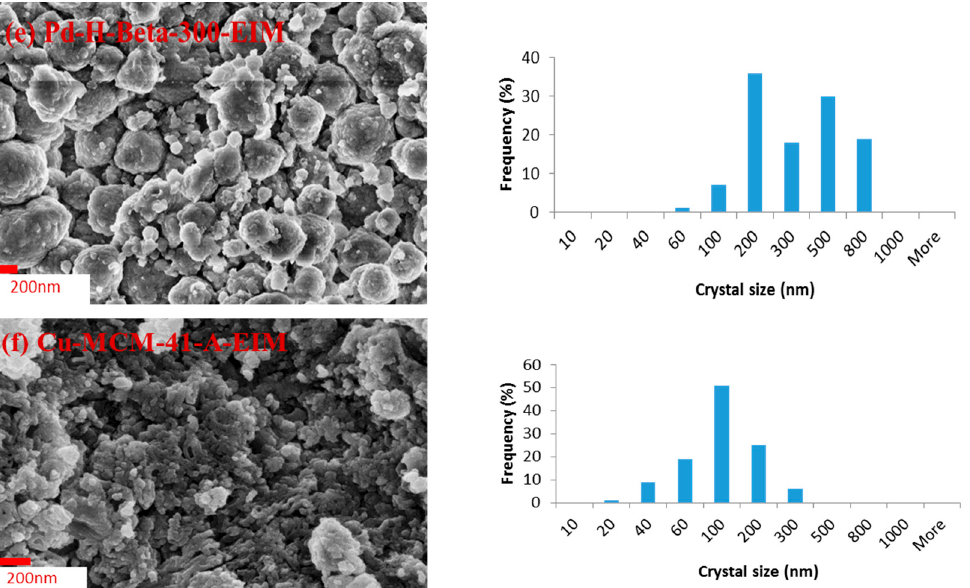
Figure 2. SEM image and crystal size distribution histogram of ( a ) Pt-MCM-41-IS. ( b ) Ru-MCM-41-IS catalyst. ( c ) Pd-H-Y-12-EIM. ( d ) Pt-H-Y-12-EIM. ( e ) Pd-H-Beta-300-EIM and ( f ) Cu-MCM-41-A-EIM catalysts. Table 3. Average crystal size and metal (Pt, Ru, Pd and Cu) content of Pt-MCM-41-IS, Ru-MCM-41- IS, Pd-H-Y-12-EIM, Pt-H-Y-12-EIM, Pd-H-Beta-300-EIM and Cu-MCM-41-A-EIM catalysts.